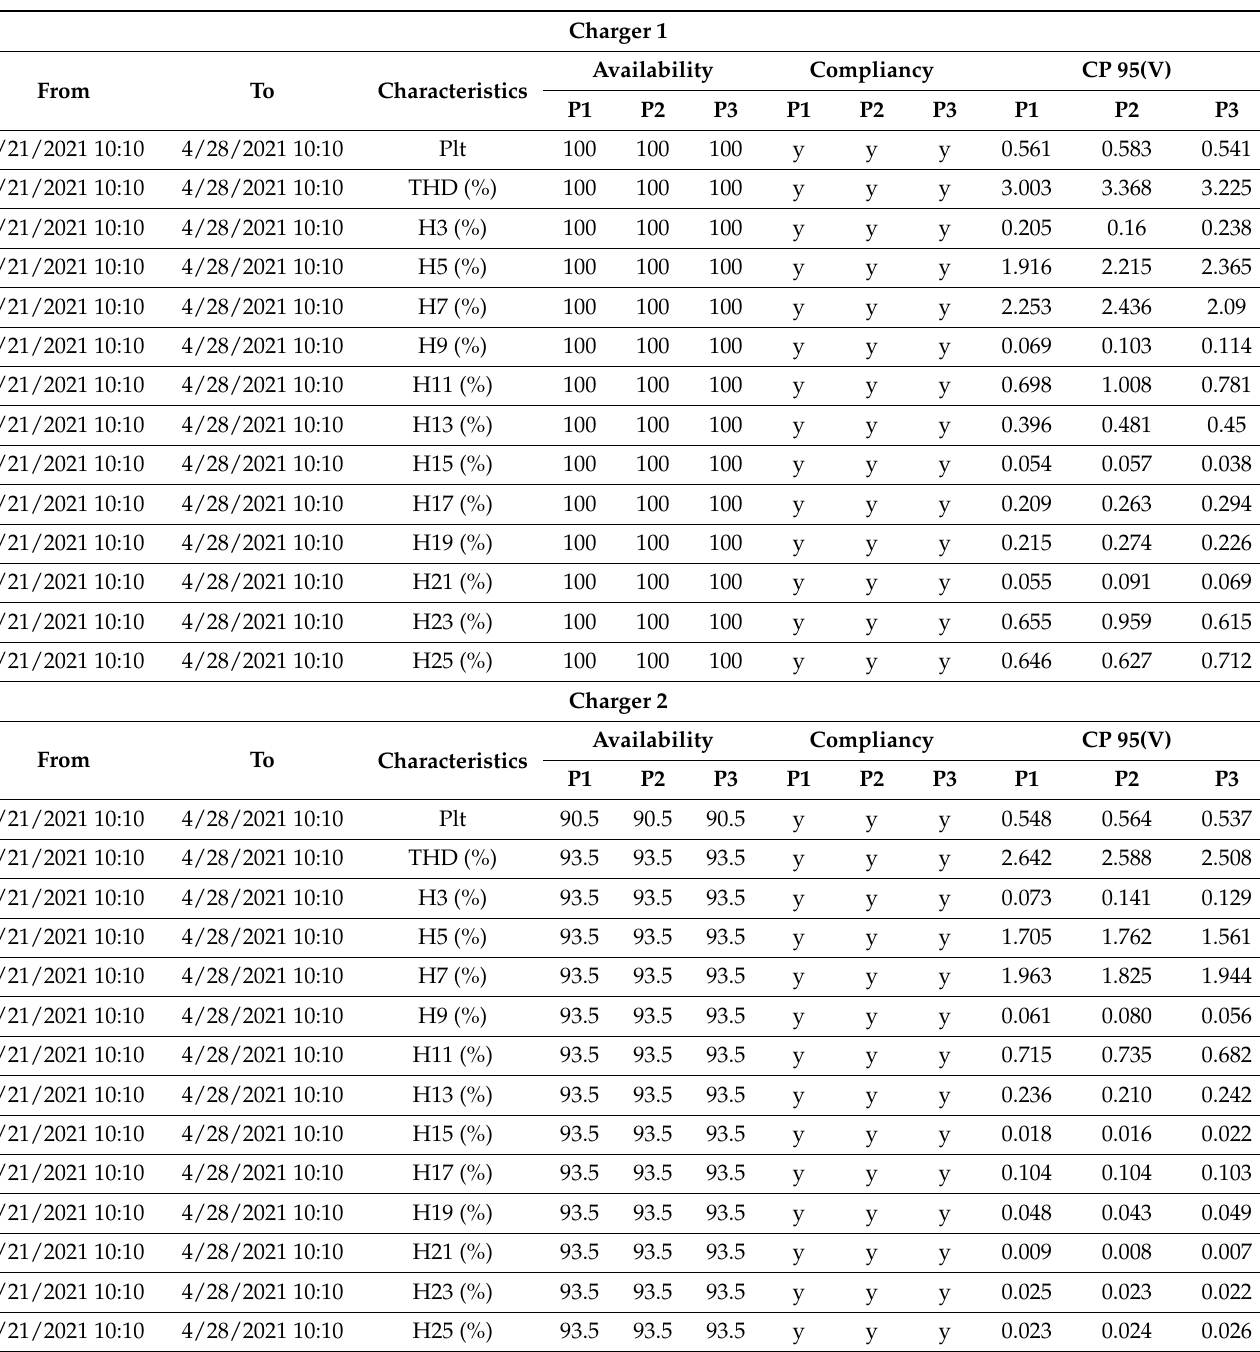
Table 2. Compliancy with EN 50160.